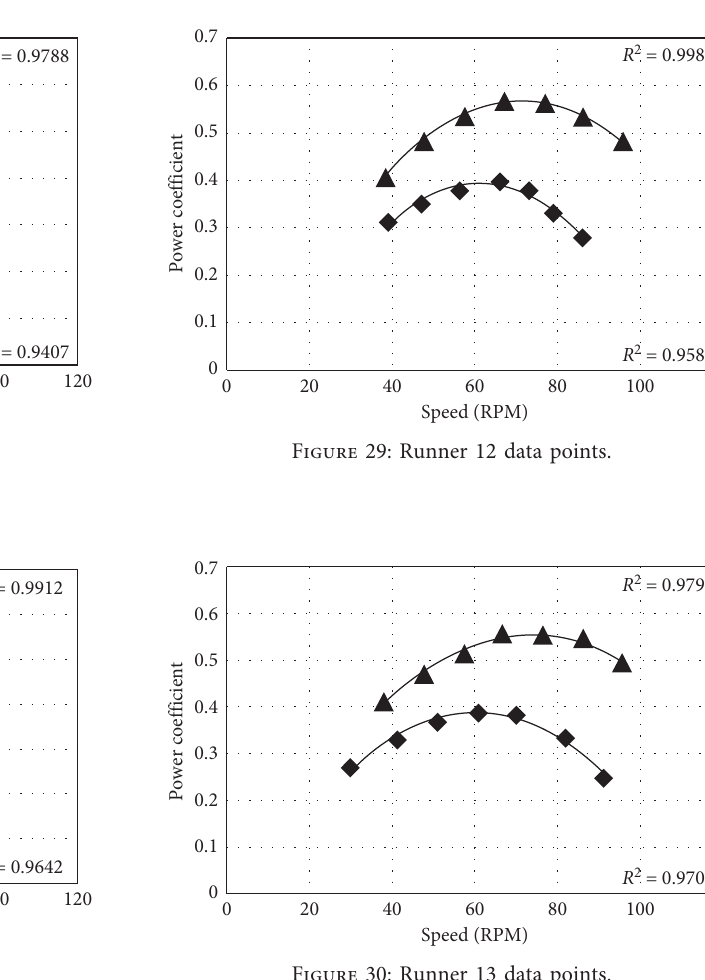
Figure 30: Runner 13 data points.